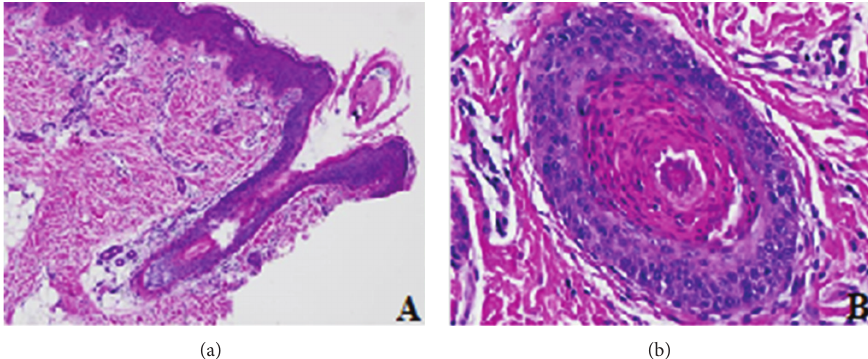
Figure 2: A skin biopsy from left thigh performed at 12 months showed epidermis with irregular acanthosis and orthokeratotic lamellar hyperkeratosis (a). The hair follicles demonstrate absence of hair shaft and are fulfilled by parakeratotic hyperkeratosis (b).